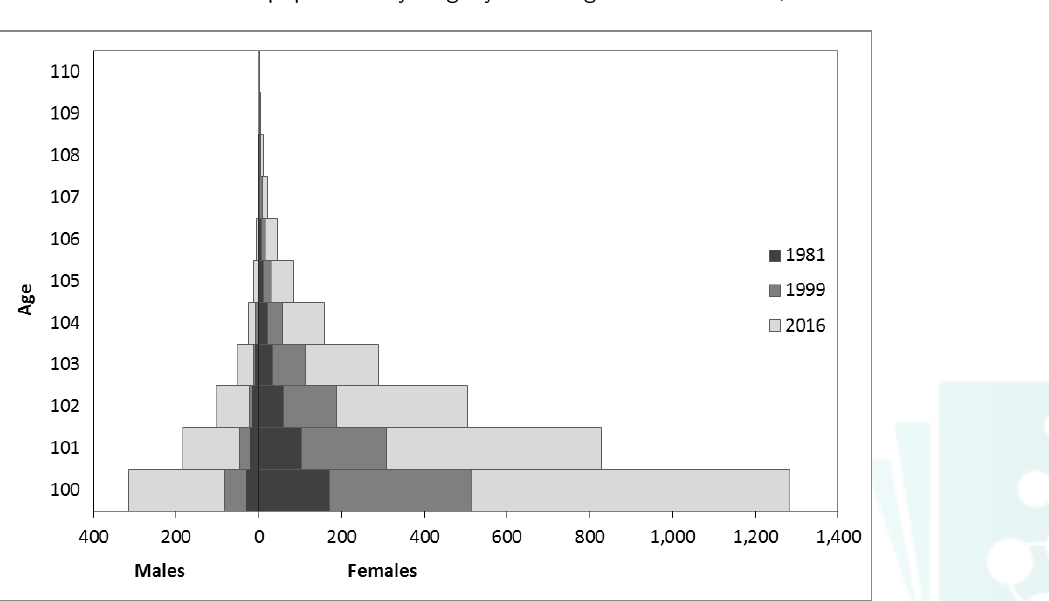
Figure 5: Australia’s centenarian population by single years of age and sex in 1981, 1999 and